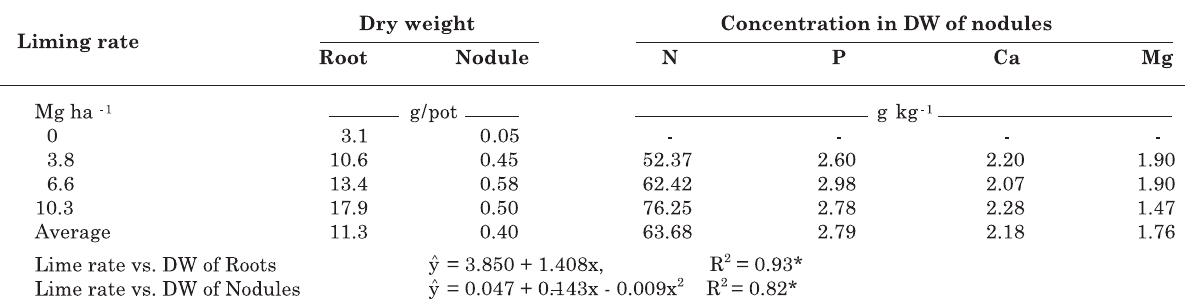
Table 4. Influence of lime treatments on root dry matter, nodule dry matter and N, P, Ca and Mg concentrations in alfalfa nodule dry matter after second